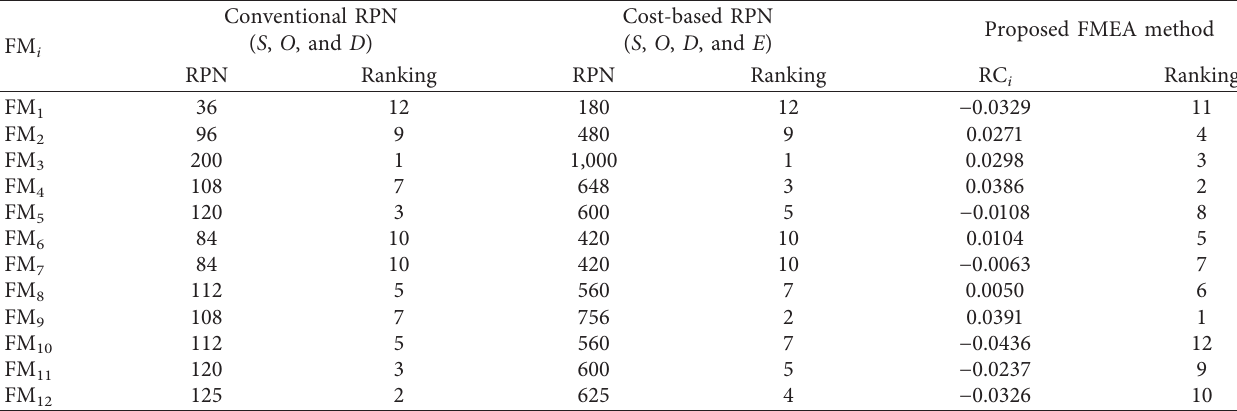
Table 6: Calculation results and rankings obtained with the three